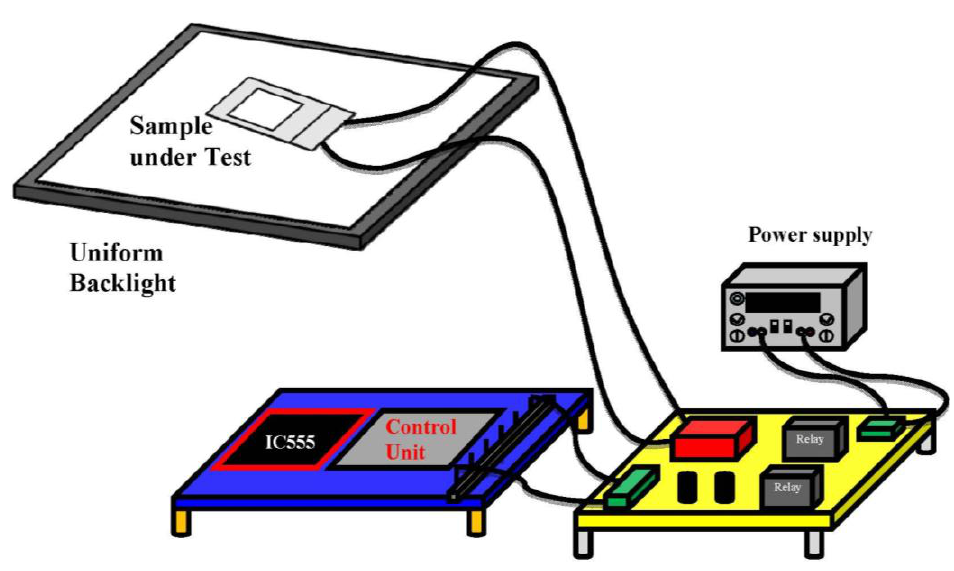
Figure 7. Setup of the simulated ESD